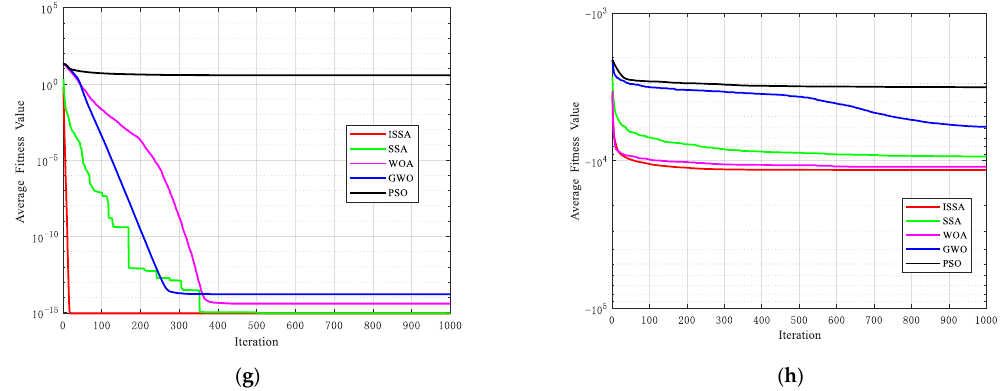
Figure 8. Test Function Convergence Plot. ( a ) F 1 ; ( b ) F 2 ; ( c ) F 3 ; ( d ) F 4 ; ( e ) F 5 ; ( f ) F 6 ; ( g ) F 7 ; ( h ) F 8 .